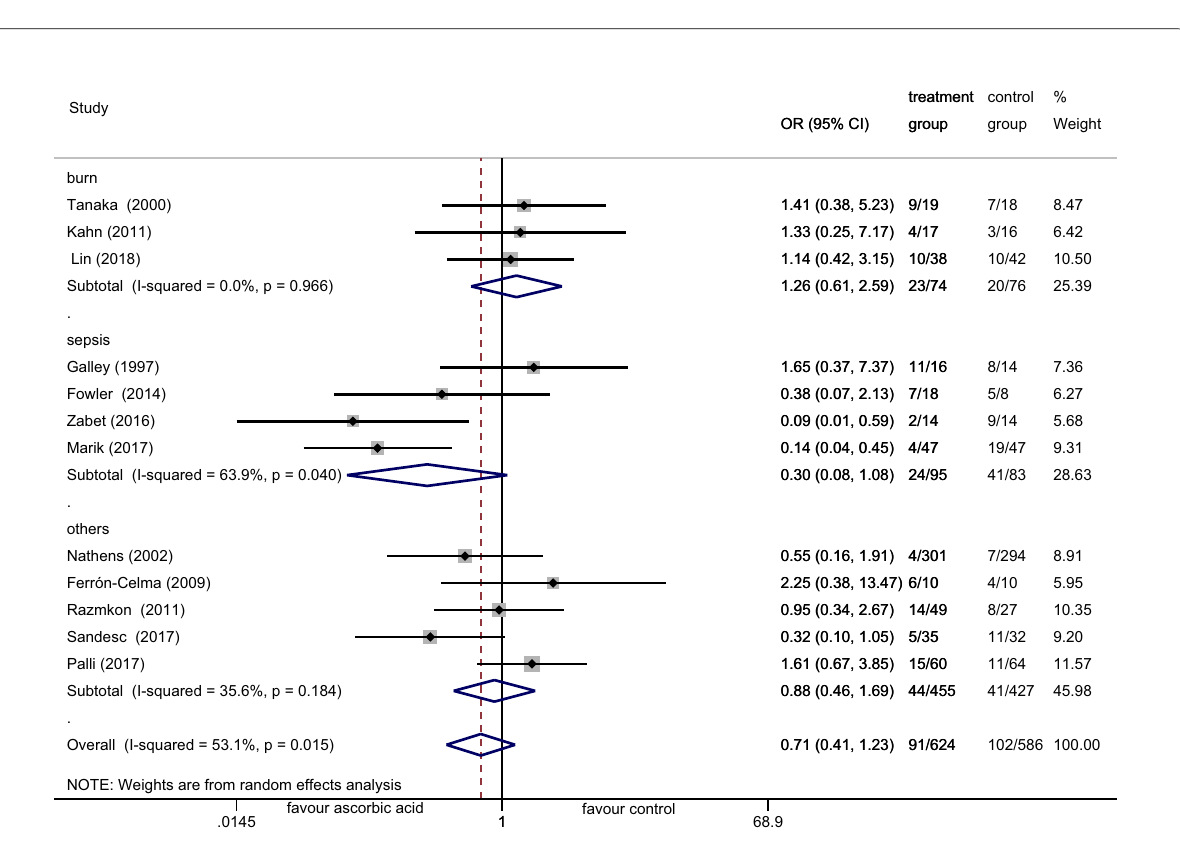
Fig. 4 Forest plot of the effect of IV AA on mortality at the final follow‑up when compared by the characteristics of